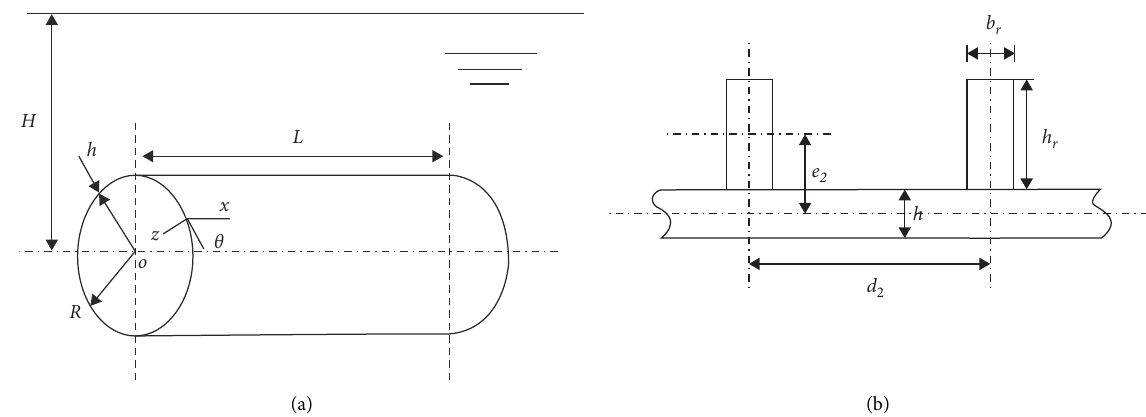
Figure 1: Coupling model. (a) Ring-stiffened cylindrical shell. (b) Ring rib